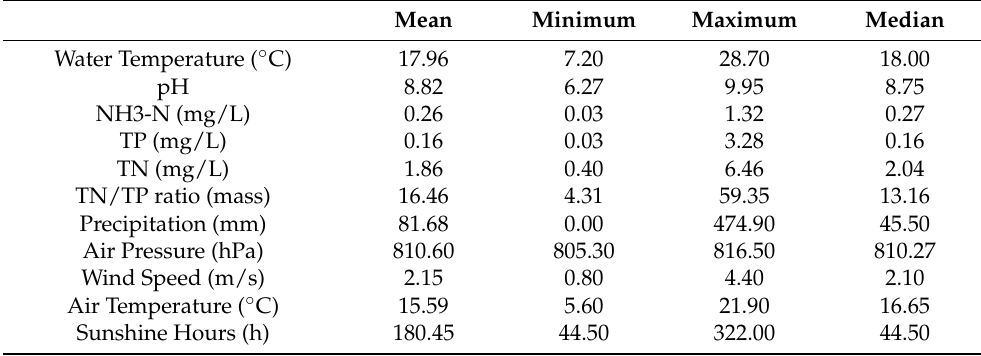
Table 1. The minimum, median, mean, and maximum monthly values of physical, chemical, and biological variables in Lake Dianchi. Abbreviations: TN, total nitrogen; TP, total